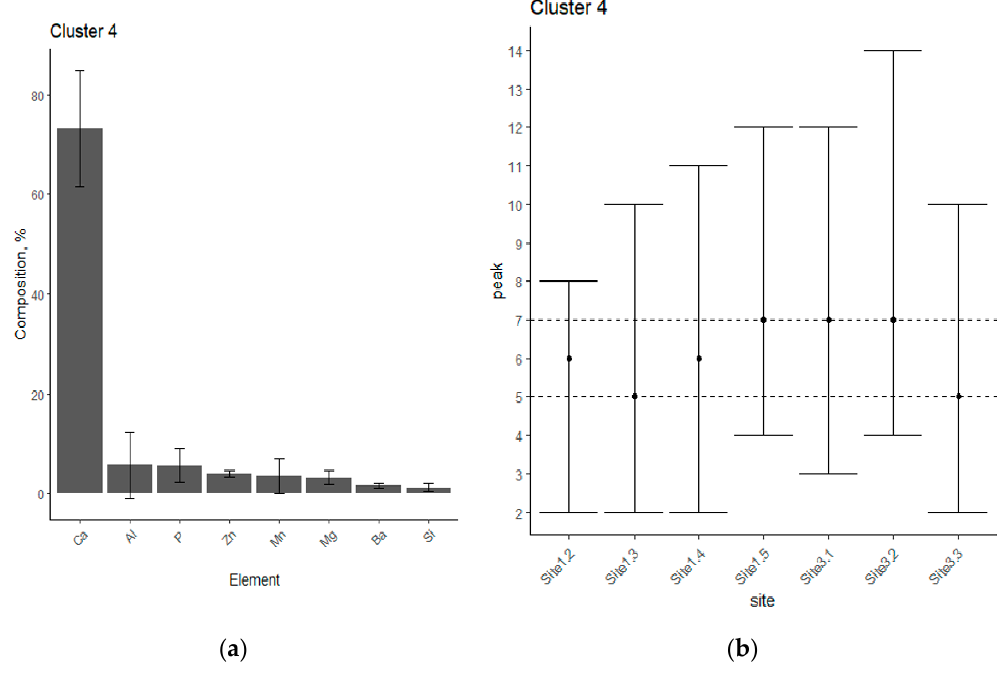
Figure 7. ( a ) Average chemical composition and standard deviation of the components in cluster 4; ( b ) extraction peak location and their windows of extraction for cluster 4 components.